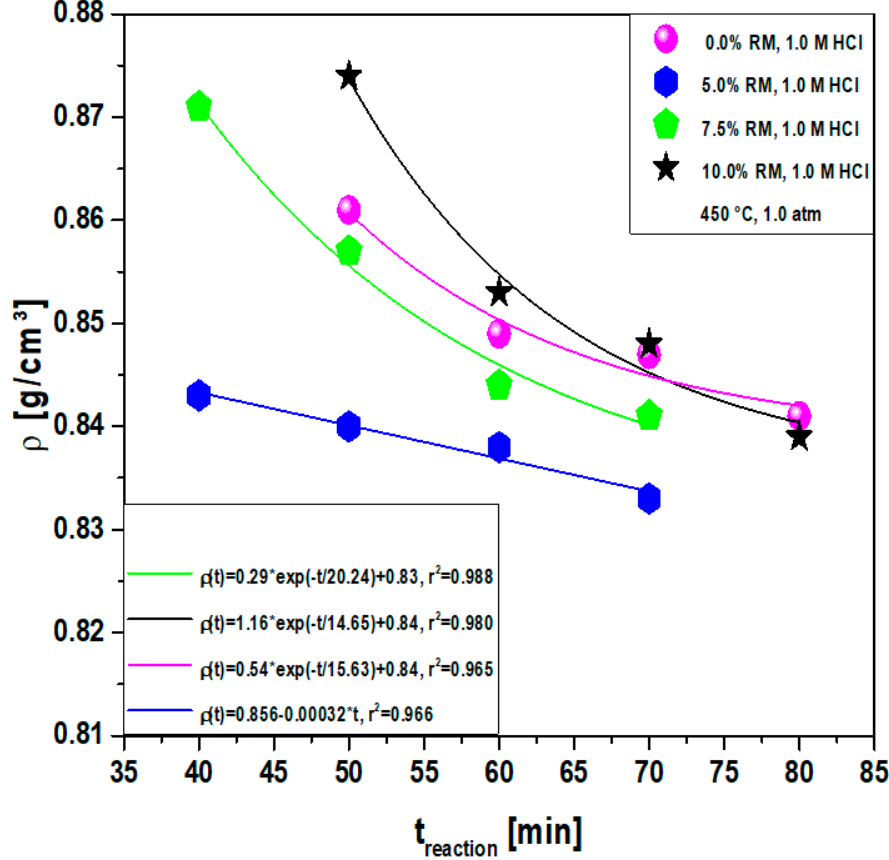
Figure 13. Effect of reaction time on the density of bio-oil obtained through the upgrading process.